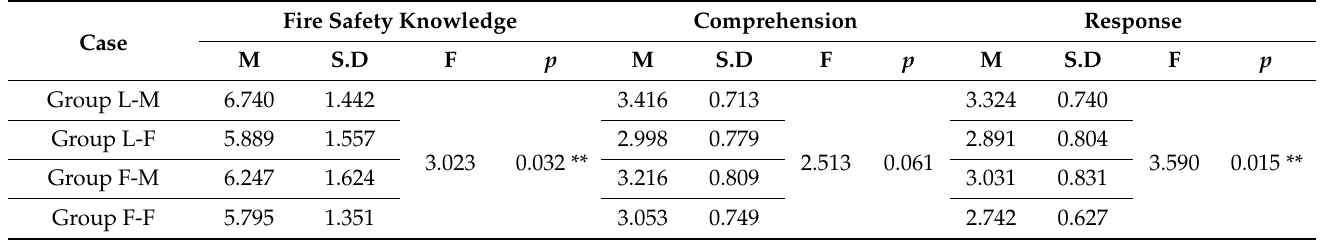
Table 6. Fire safety knowledge, comprehension, and response scores and the ANOVA results of each respondent